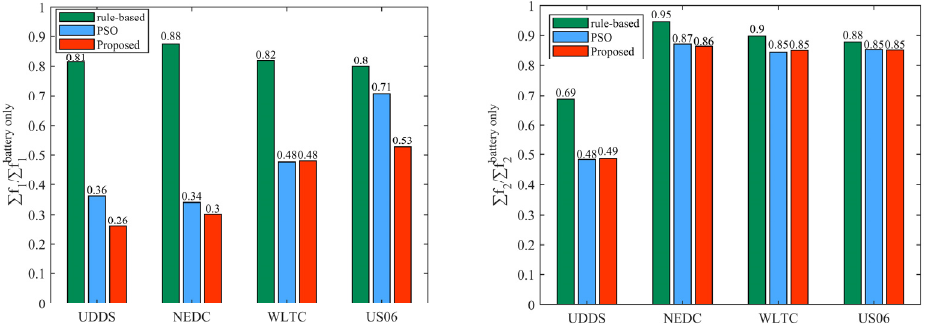
Figure 11. Statistical diagram of the battery current fluctuation parameter ∑ f 1 and the battery current amplitude parameter ∑ f 2 under different driving cycles and methods.